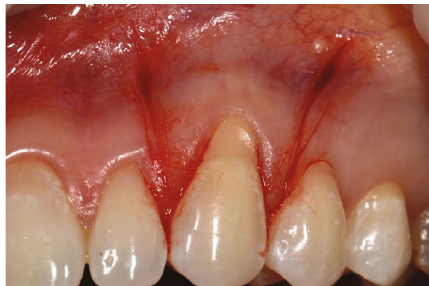
Figure 7: Preparation of the recipient site: with an intrasulcular incision and two diverging vertical incisions up to the alveolar mucosa.